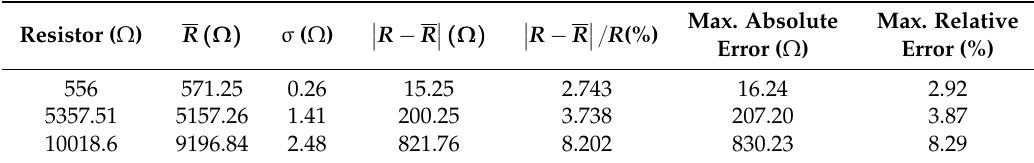
Table 1. Accuracy data for Experiment